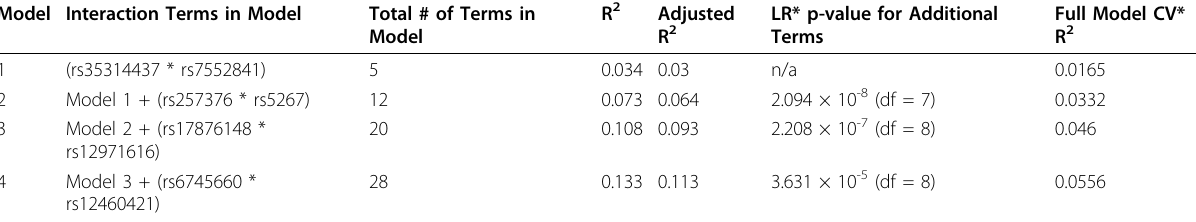
Table 4 Outline of model improvement with addition of each SNP-SNP interaction included in final multivariable model Model Interaction Terms in